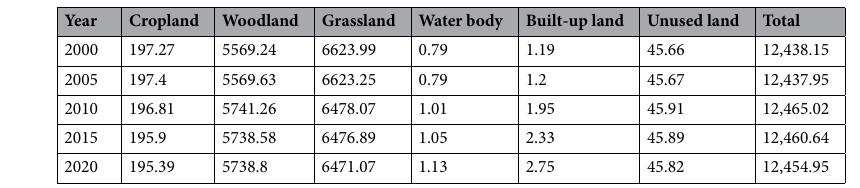
Table 3. Carbon storage in the Western Sichuan Plateau from 2000 to 2020 (10 6